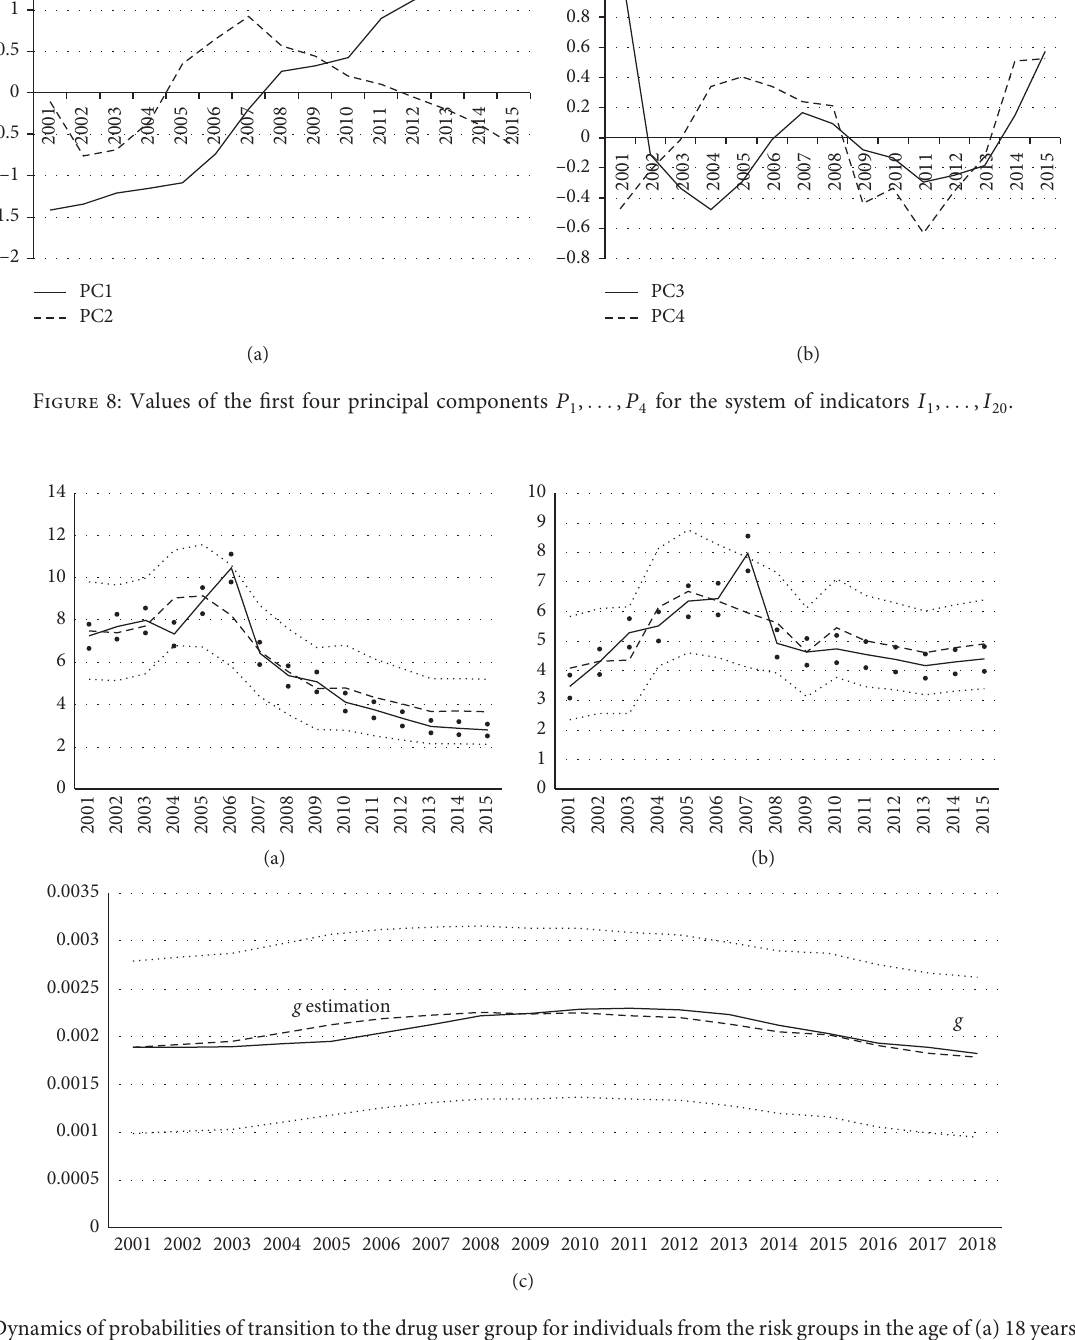
Figure 9: Dynamics of probabilities of transition to the drug user group for individuals from the risk groups in the age of (a) 18 years and (b) 25 years and (c) all age groups. On the vertical axis, n is 10,000.